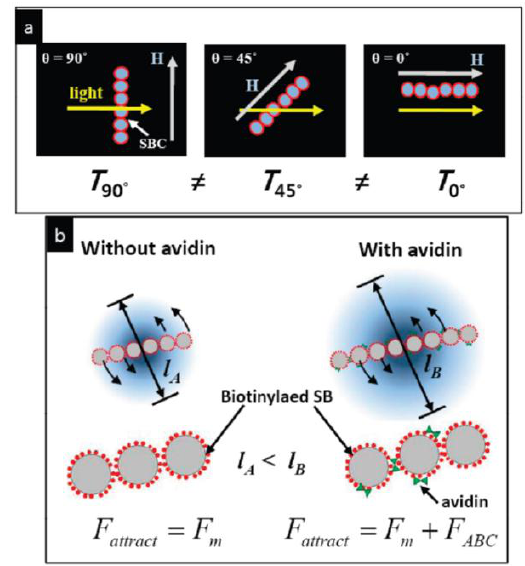
Figure 10. Sketch of analyte detection by magnetically rotated particle chains. ( a ) The transmitted light intensity depends on the orientation of the magnetic particle chains, which can be modified by the direction of the applied magnetic field; ( b ) When the magnetic field is rotated, the magnetic particle chains follow the rotating magnetic field. The medium length of the magnetic particle chains depends on the strength of the attractive force (F attract ) between individual particles, which is stronger for analyte-carrying particles due to the binding strength F ABC , which adds to the magnetic dipolar interaction F m . As the magnetic particle chain length also influences the modulation intensity of the transmitted light when the particle chains are rotated, the transmitted light modulation is indicative of the concentration of analyte molecules in the sample solution. Reprinted with permission from [231]. Copyright 2010, American Chemical Society.